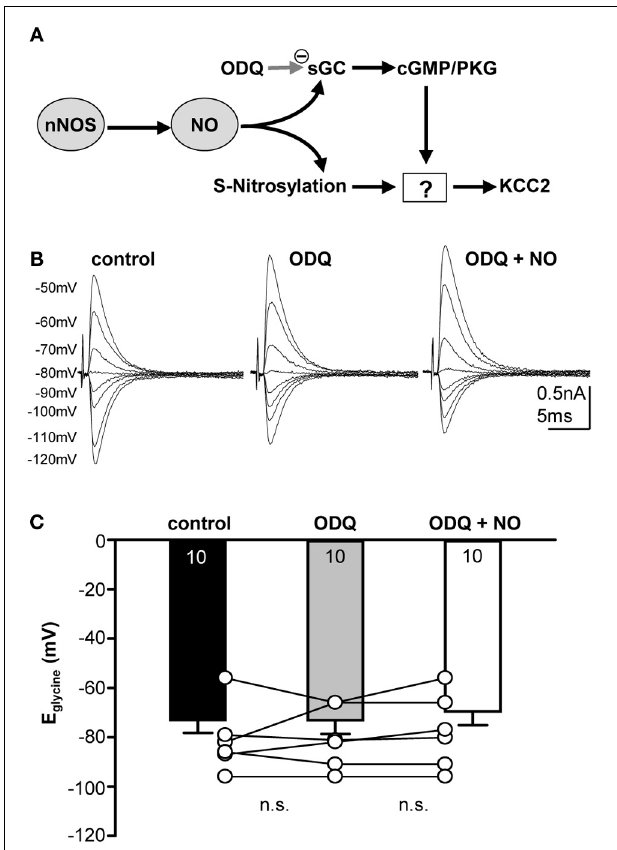
FIGURE 4 | Nitrergic signaling acting on KCC2 is cGMP-dependent. (A) Cartoon of possible intracellular signaling mechanisms by NO. (B) Glycinergic IPSCs were evoked in a mouse SPN neuron by electrical stimulation of the MNTB. The command potentials ranged from − 120 to − 50mV in steps of 10mV. Blockade of sGC with ODQ prevents the depolarizing shift of the reversal potential normally observed following NO application. (C) Average data show that ODQ prevents the NO-mediated depolarizing shift in E glycine . There is no significant change between the three conditions.